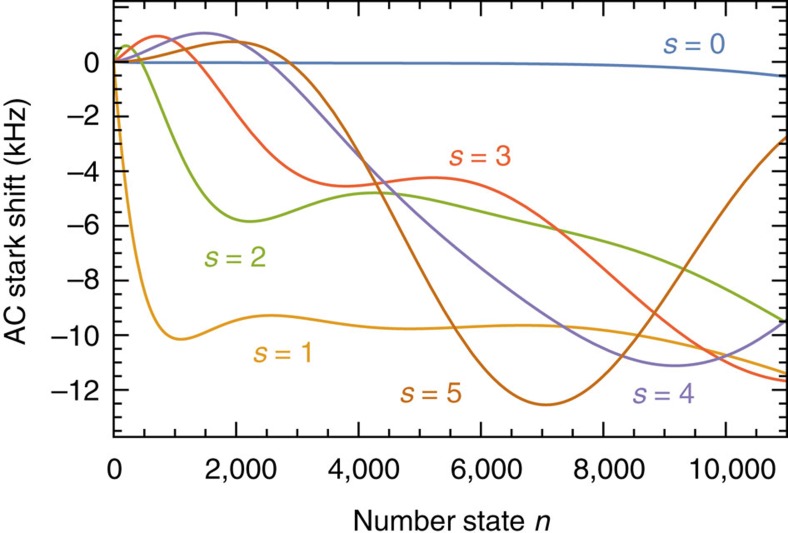
AC Stark shifts.Energy level corrections due to off-resonant coupling to motional sidebands other than the one driven, as well as to the carrier and sidebands of the |↓〉↔| L=2, J=5/2, MJ=3/2〉 transition at our 3.83 G magnetic field when the laser is resonant with the transition for n=0.